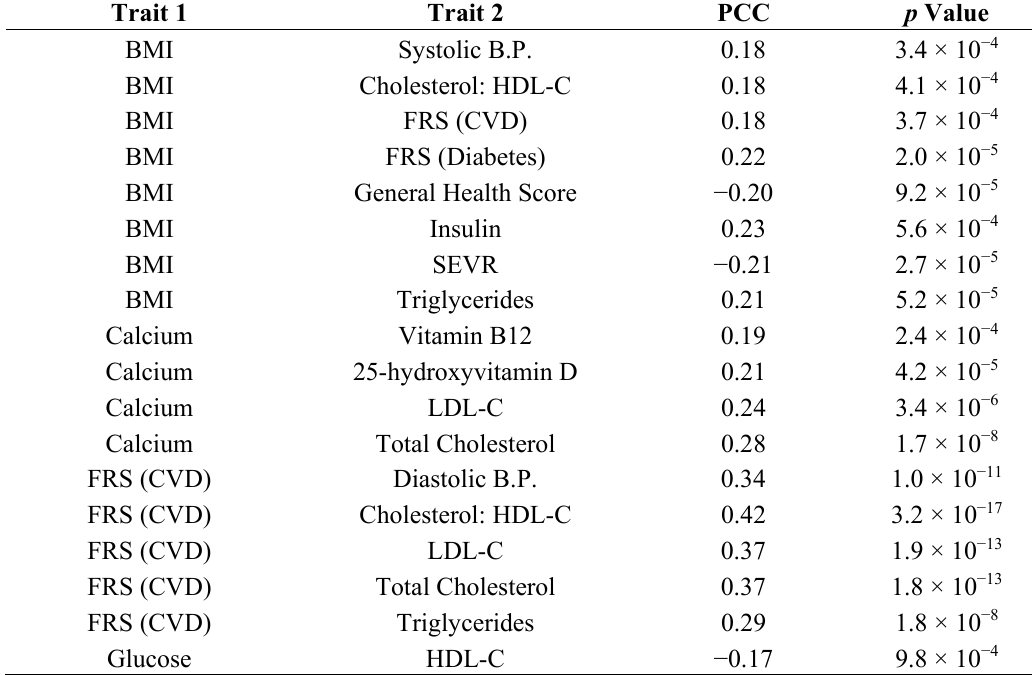
Appendix Table A2. Correlation between slopes of